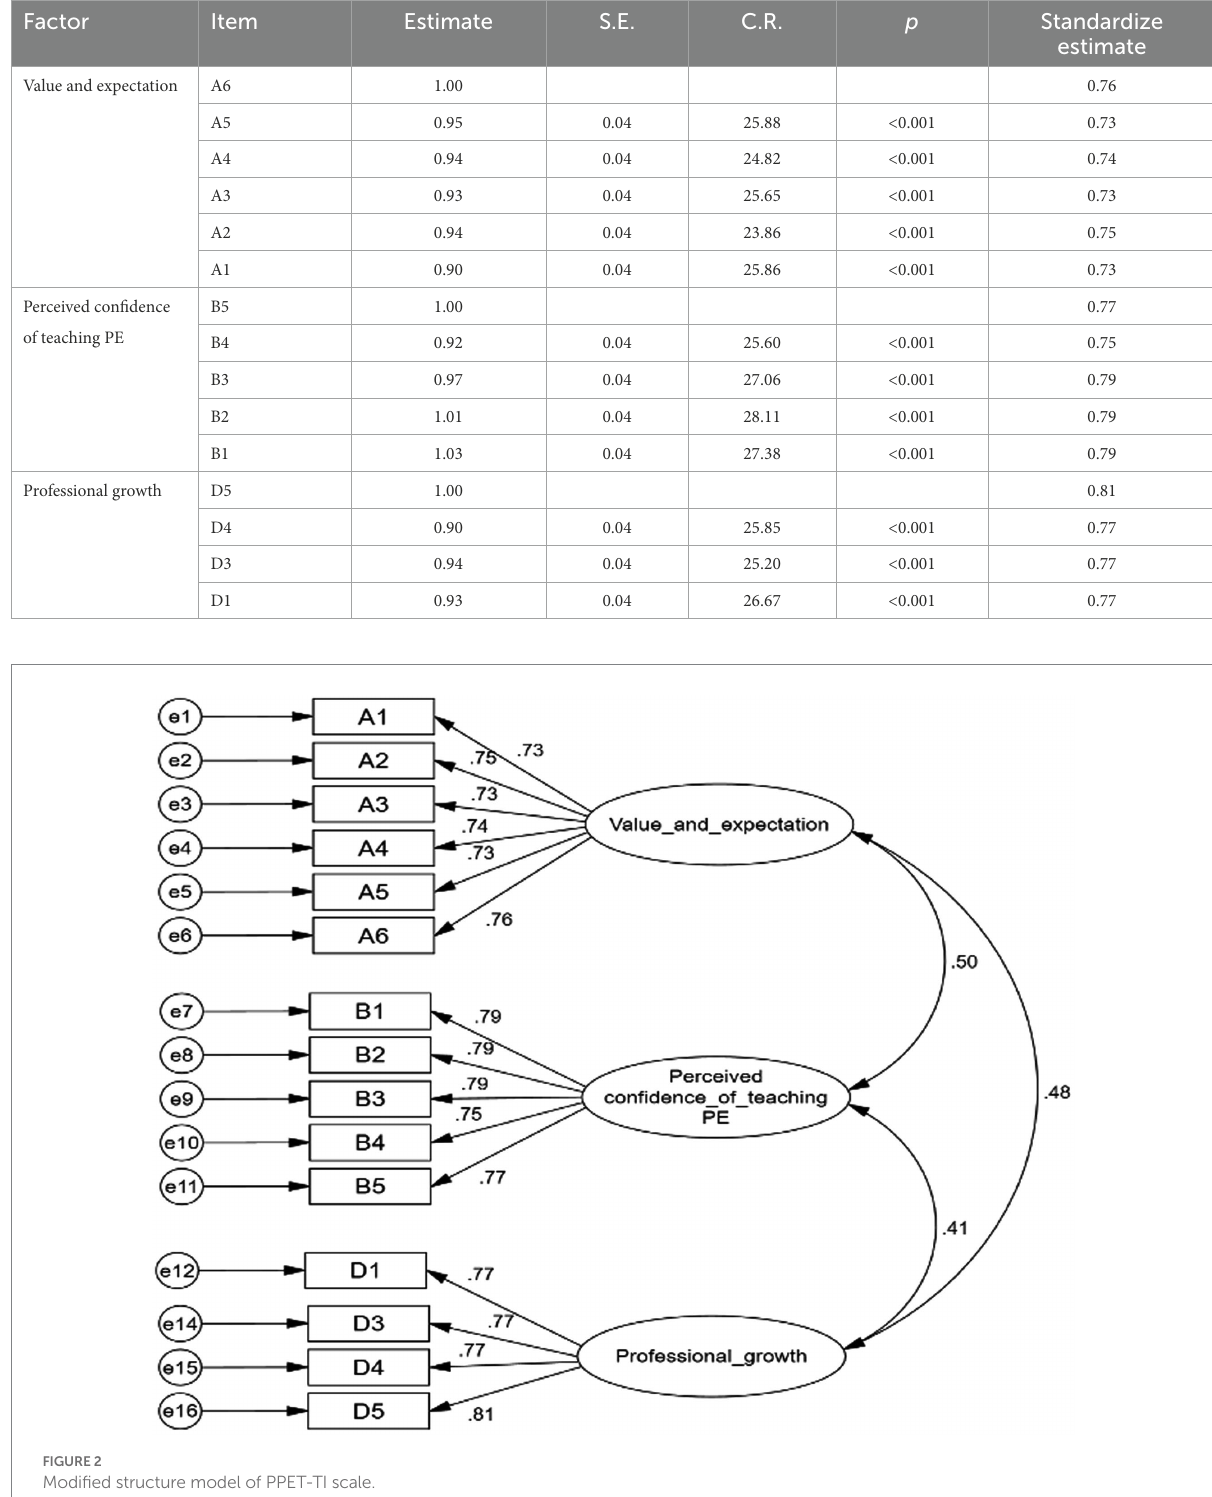
FIGURE 2 Modified structure model of PPET-TI